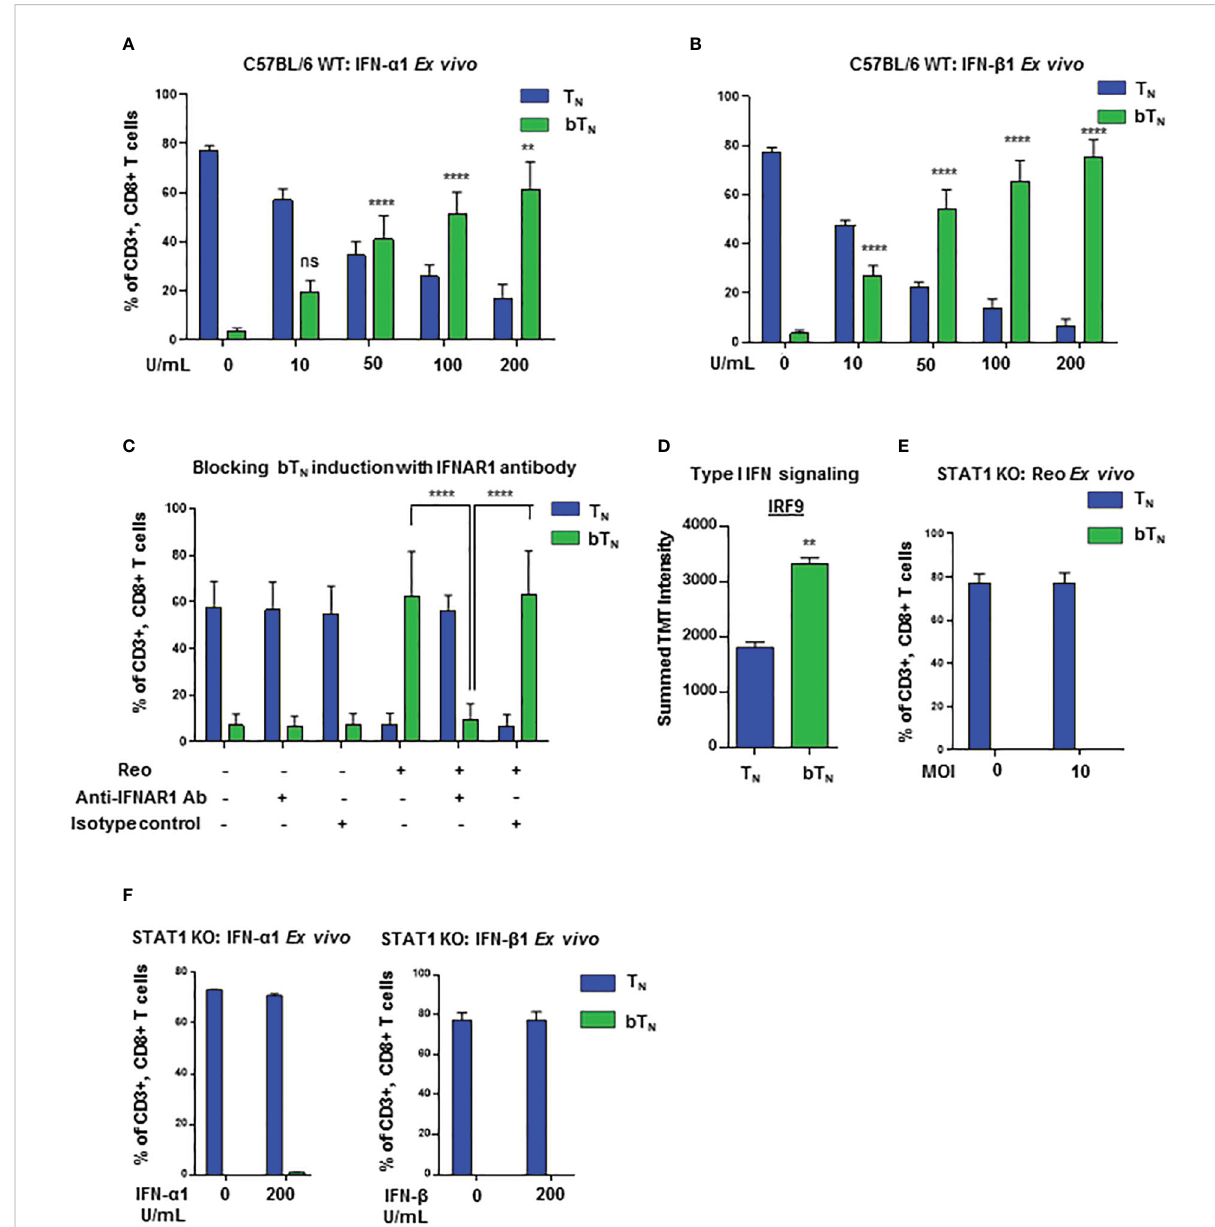
FIGURE 3 Induction of CD8 bT N cells occurs in a STAT1-dependent manner. Bar graphs showing induction of CD8 bT N cells upon ex vivo treatment of splenocytes from C57BL/6 mice with (A) varying concentrations of IFN- a 1 from 10 U/mL- 200 U/mL (n=3 independent experiments), (B) varying concentrations of IFN- b 1 from 10 U/mL- 200 U/mL (n=3 independent experiments) and (C) reovirus (MOI = 10) + IFNAR1 antibody (10µg/mL, n=3 independent experiments; Signi fi cance shown as indicated in fi gure) or isotype control. (D) IRF9 protein intensity (Two-tailed Student ’ s t-test). (E, F) Bar graphs for induction of CD8 bT N cells upon ex vivo treatment of splenocytes from STAT1 KO mice with reovirus MoI = 10 (n=3 independent experiments) (E) and, IFN- a 1 and IFN b 1 (200 units (U)/ml each) (n=2 independent experiements) (F) . Two-way ANOVA with Tukey ’ s multiple comparisons test and 95% con fi dence interval was used for statistical analysis unless otherwise indicated. Signi fi cance has been indicated for CD8 bT N cells in treatment conditions versus non-treated conditions unless otherwise indicated. Not signi fi cant (ns) = p > 0.05; **p < 0.01; **** p